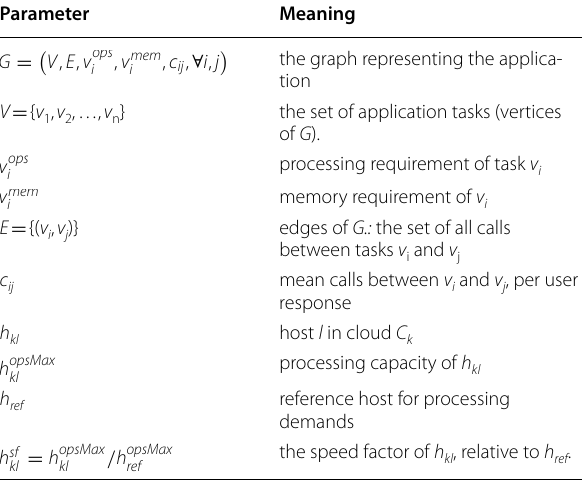
Table 3 Application Model and Application Graph Property